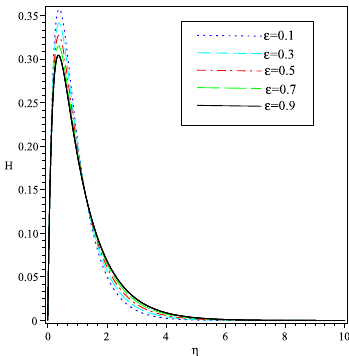
Fig. 3: The profile micro-rotation H ( η ) obtained by the direct RBFs for different values of ε at β = 6 and ϕ = 0 .